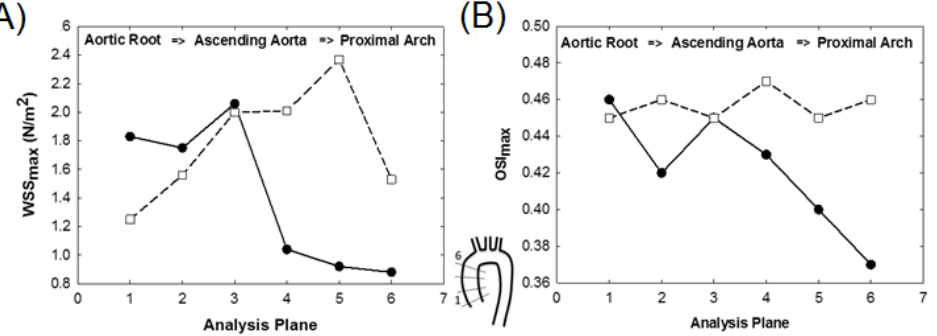
Figure 4. Distribution of ( A ) WSS max and ( B ) OSI max over each analysis plane within the ascending aorta for pre-operative ( ●) and post - operative (□) models, as indicated by the scheme in the center.